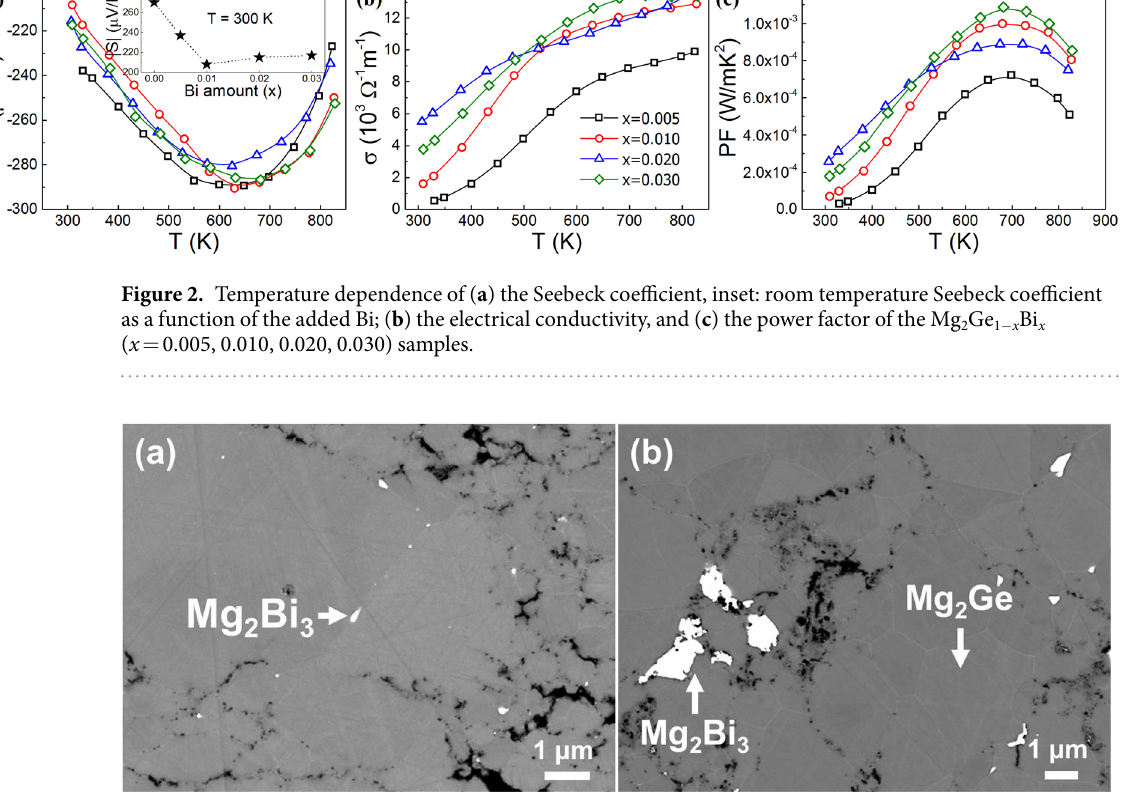
Figure 3. Backscattered electron micrographs of Mg 2 Ge 1 − x Bi x samples for ( a ) x = 0.005, ( b ) x = 0.020. The interaction volume between the beam and the sample is taken into account, leading to the use of low acceleration voltages in order to distinguish the elements in the precipitates from the surrounding